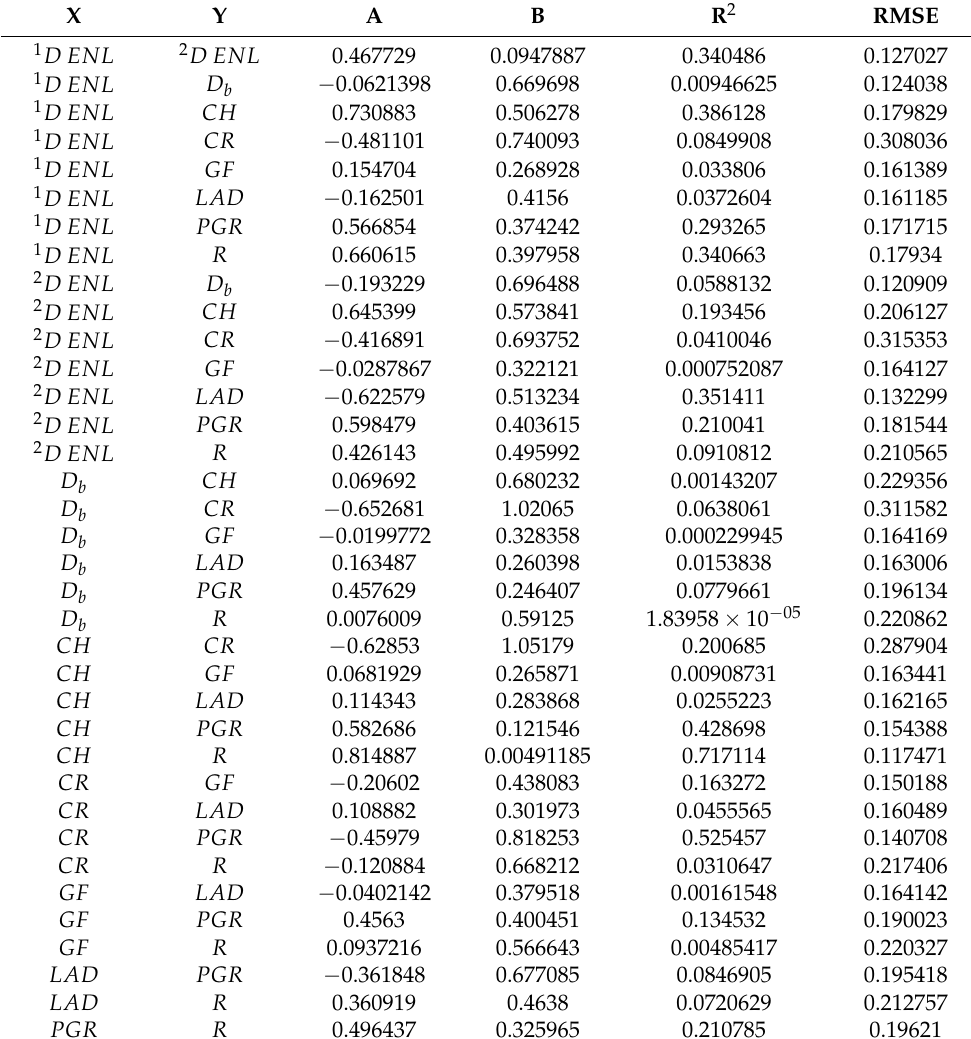
Table A10. Overview of ULS linear regression at 1m grid